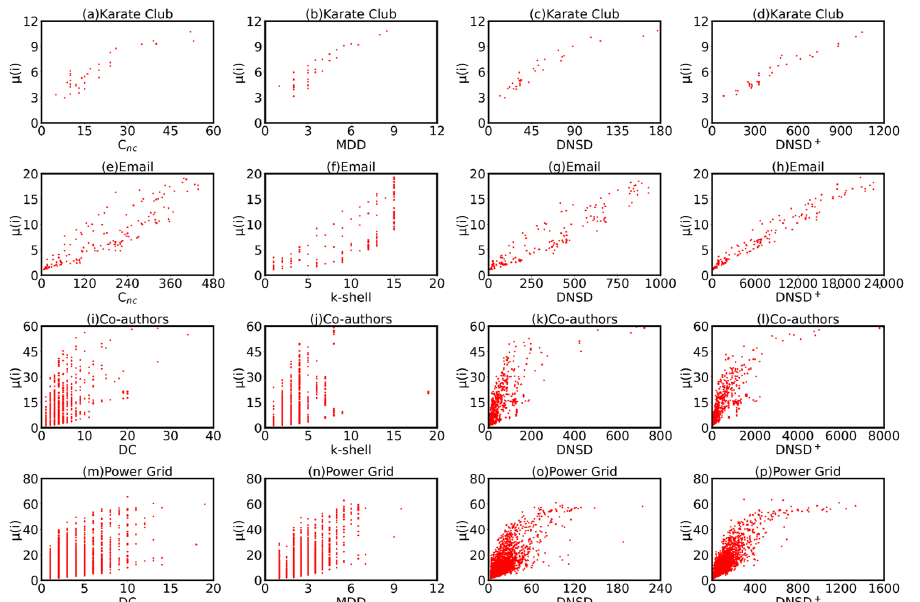
Figure 4. The spreading capacity measured by the SIR simulation in the different networks plotted with the different ranking methods: Karate Club ( a – d ); Email ( e – h ); Co-authors ( i – l ); and Power Grid ( m – p ). α is set to 0.5 and β is set to